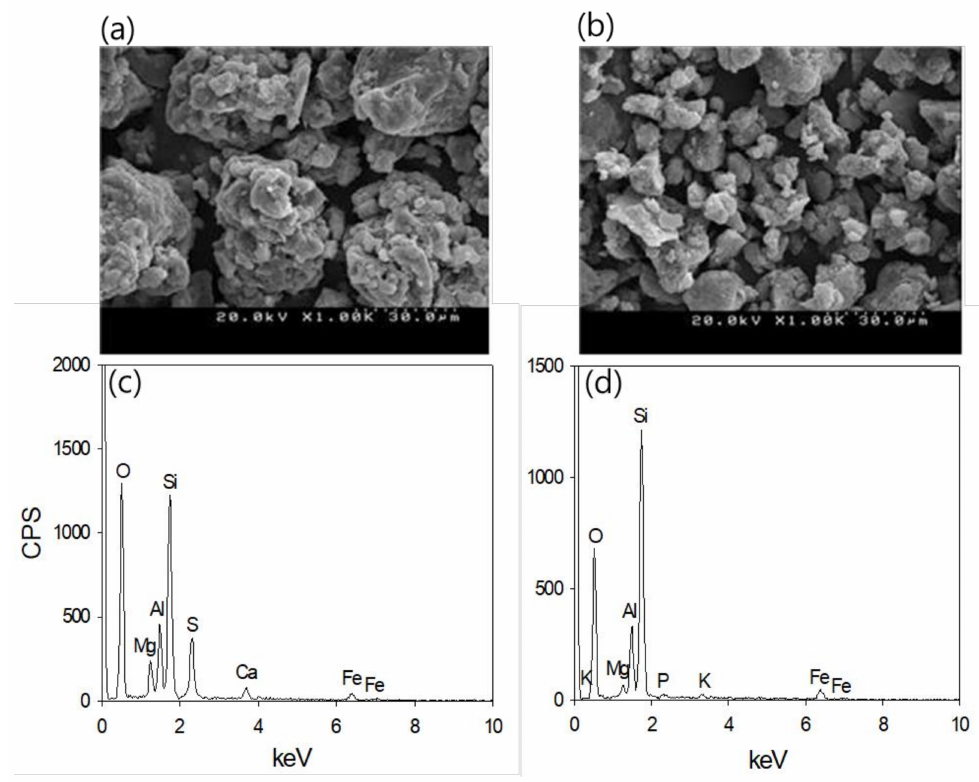
Figure 1. SEM images of ( a ) montmorillonite and ( b ) PINM, and EDS spectra of ( c ) montmorillonite and ( d )